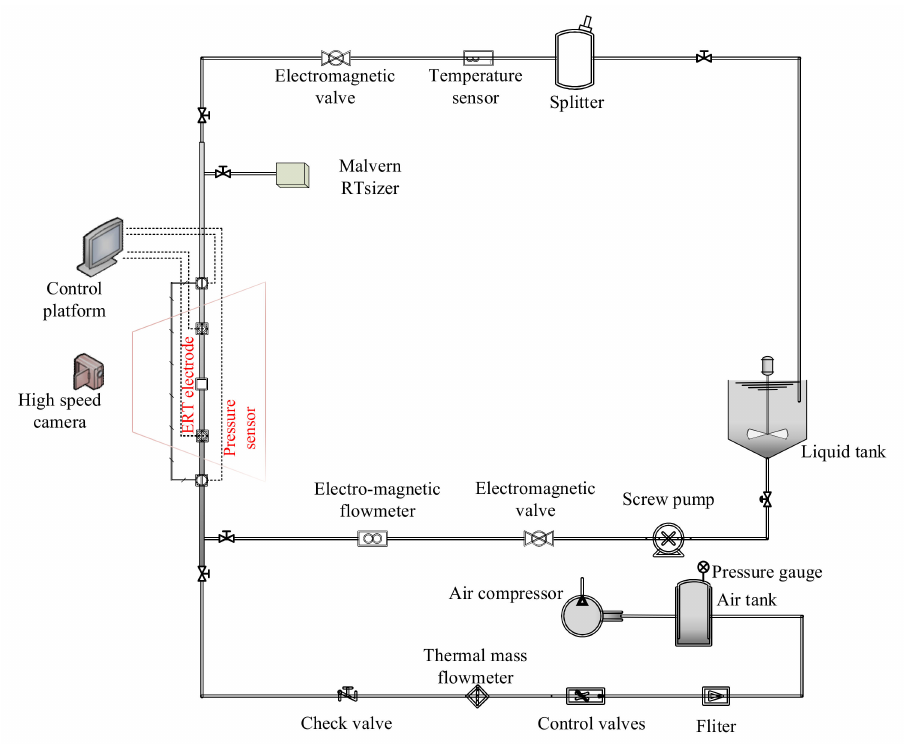
Figure 7. Experimental